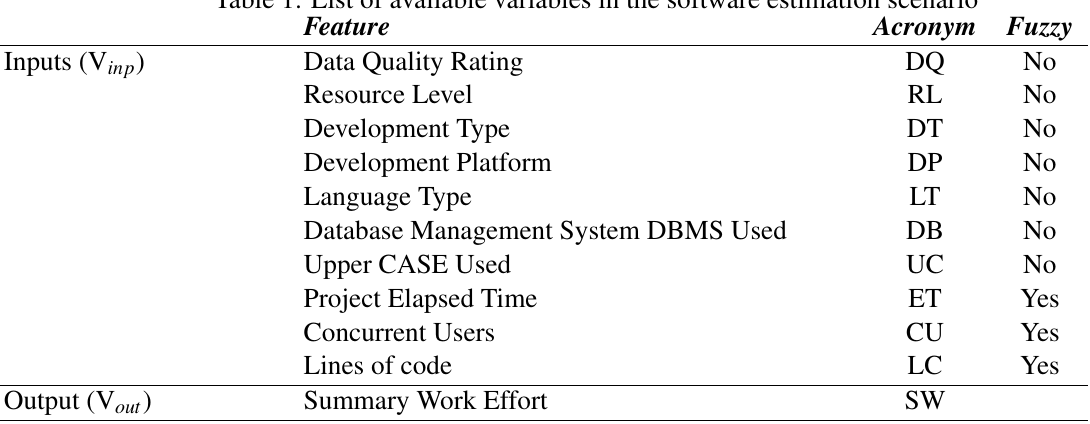
Table 1: List of available variables in the software estimation